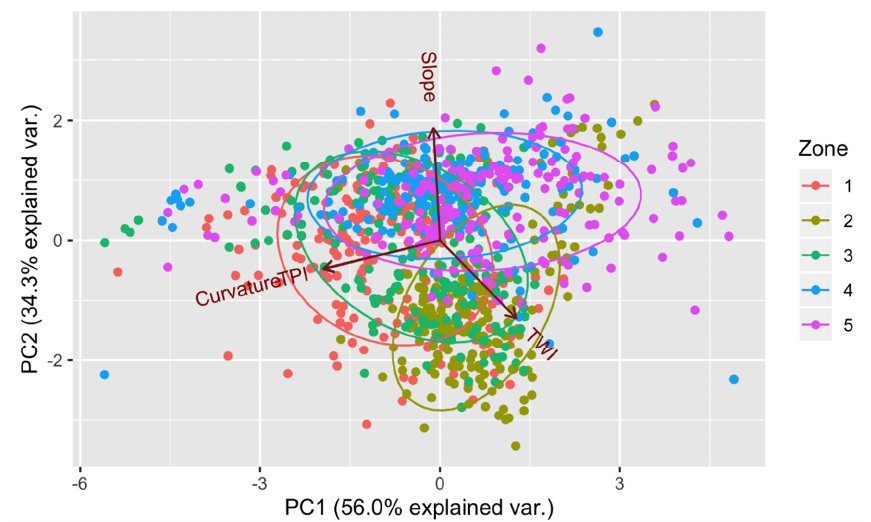
Figure 9. A principal component analysis (PCA) biplot showing topographic variation within each spatial zone established by Ward method clustering of NDVI time series from satellite imagery. The length of each vector represents the loading of each variable (slope, curvature, Topographic Position Index, Topographic Wetness Index) on each Principal Component and the angle between each pair of vectors indicates the correlation between variables. Vectors with the same direction are positively correlated, while vectors with opposing directions are negatively correlated.